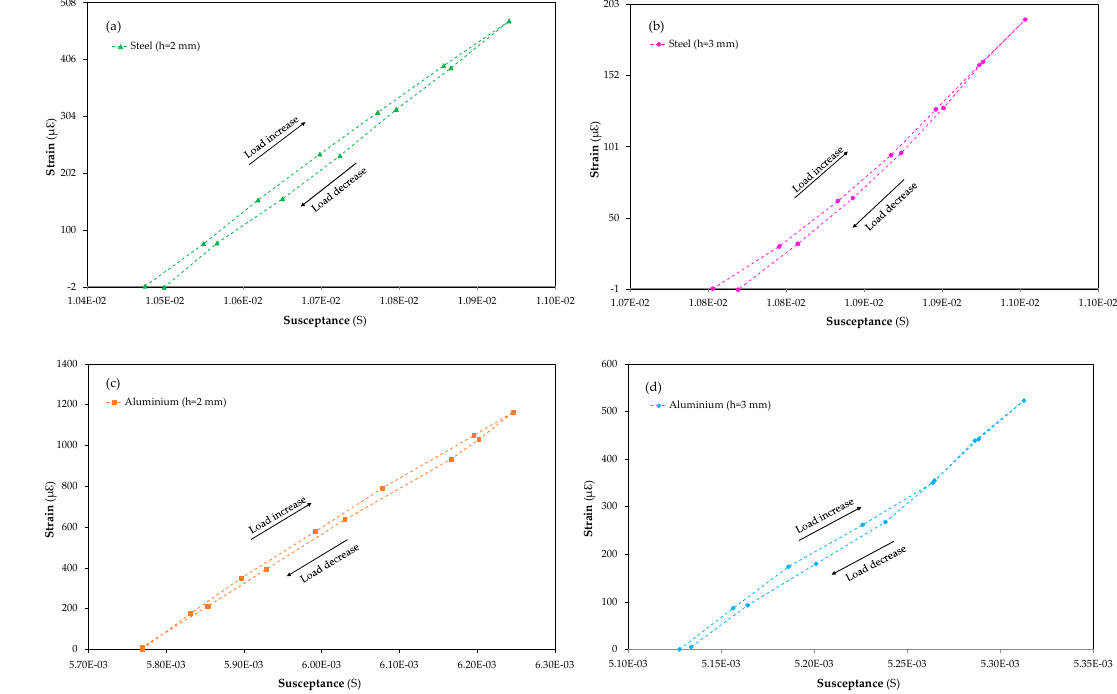
Figure 9. µ strain vs susceptance measurements for the calibration of ( a ) steel h = 2 mm, ( b ) steel h = 3 mm, ( c ) aluminium h = 2 mm and ( d ) aluminium h = 3 mm.